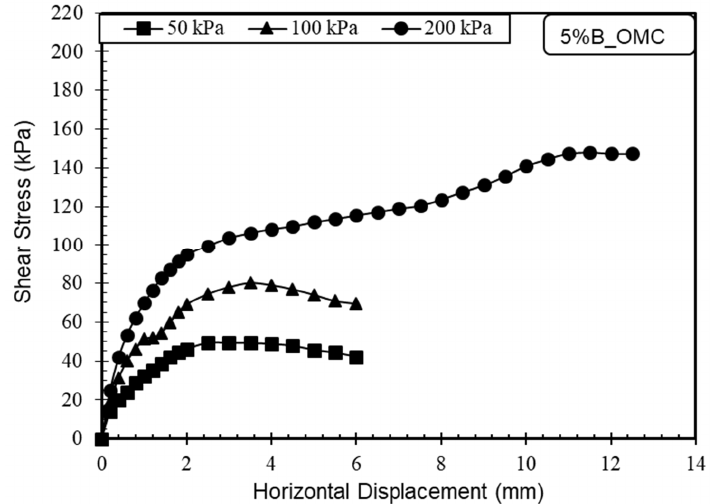
Figure 10. Horizontal displacement vs. shear stress for mixture with 5% bentonite under OMC con ‐ dition.